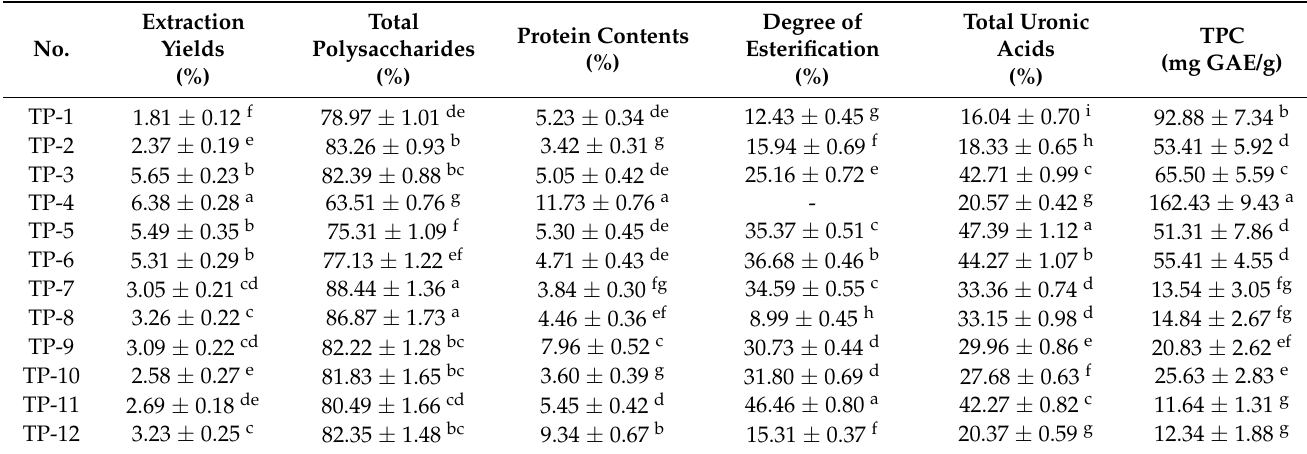
Table 2. Chemical compositions of TPs.